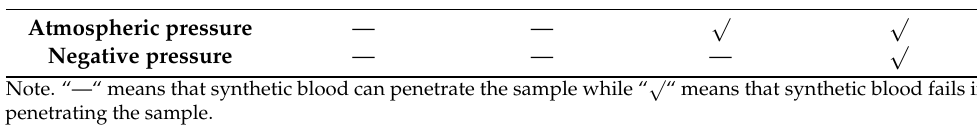
( b ) Figure 9. SEM images of ( a ) K40: ×100 ( b ) K40/PAN: ×5 K, showing the fiber morphology and diam- eter.